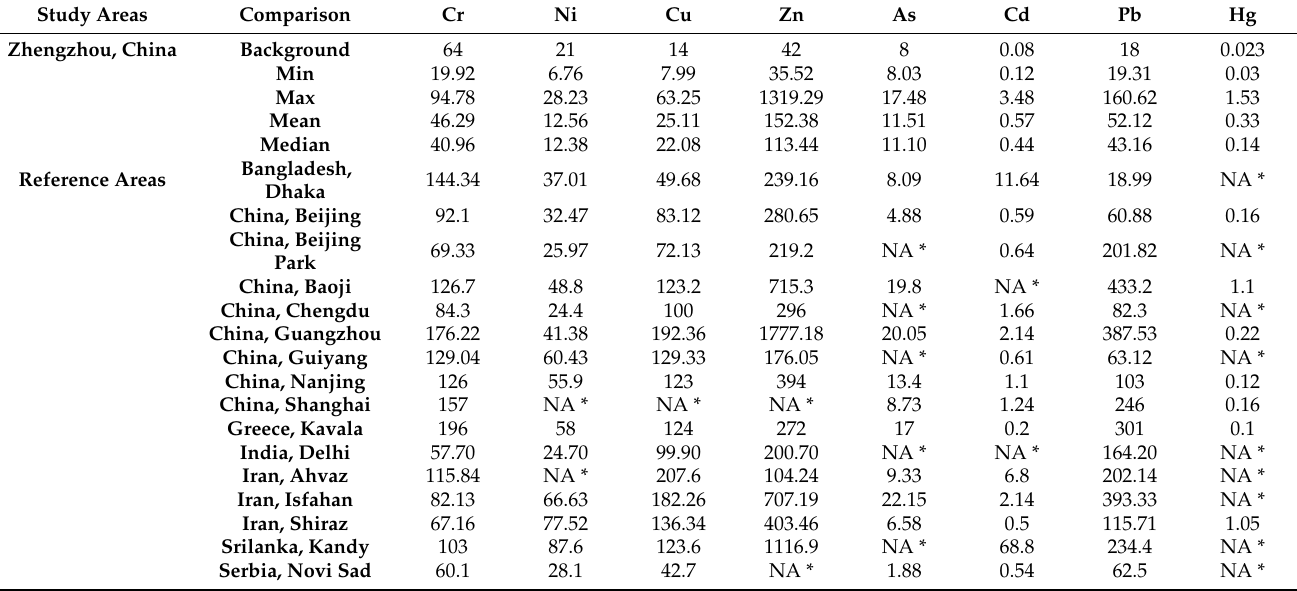
Table 2. Concentrations of heavy metals in the current study and reference areas